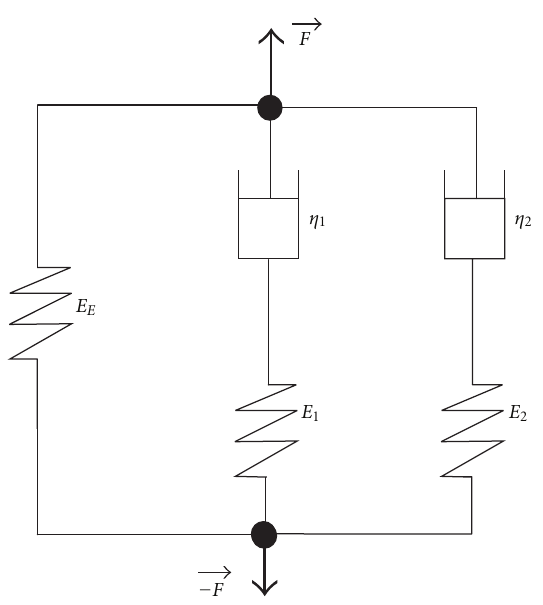
Figure 5: Viscoelastic model constituted of a spring associated in parallel with two Maxwell elements. A tensile force F is applied to this model. E E , η I , and E i are, respectively, the elastic modulus, the viscosity, and the relaxation moduli associated with the model.